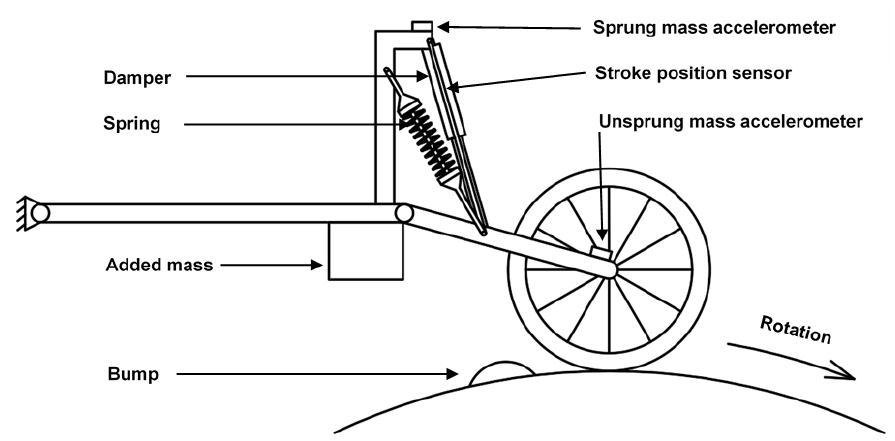
Figure 1. Experimental apparatus.